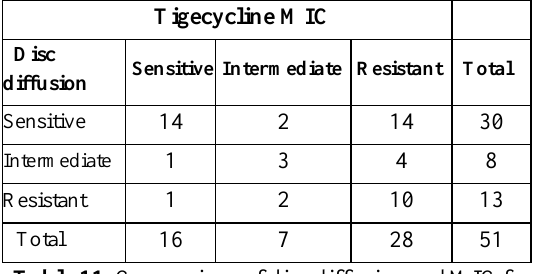
Table 3. Colistin MIC among carbapenemase producers .